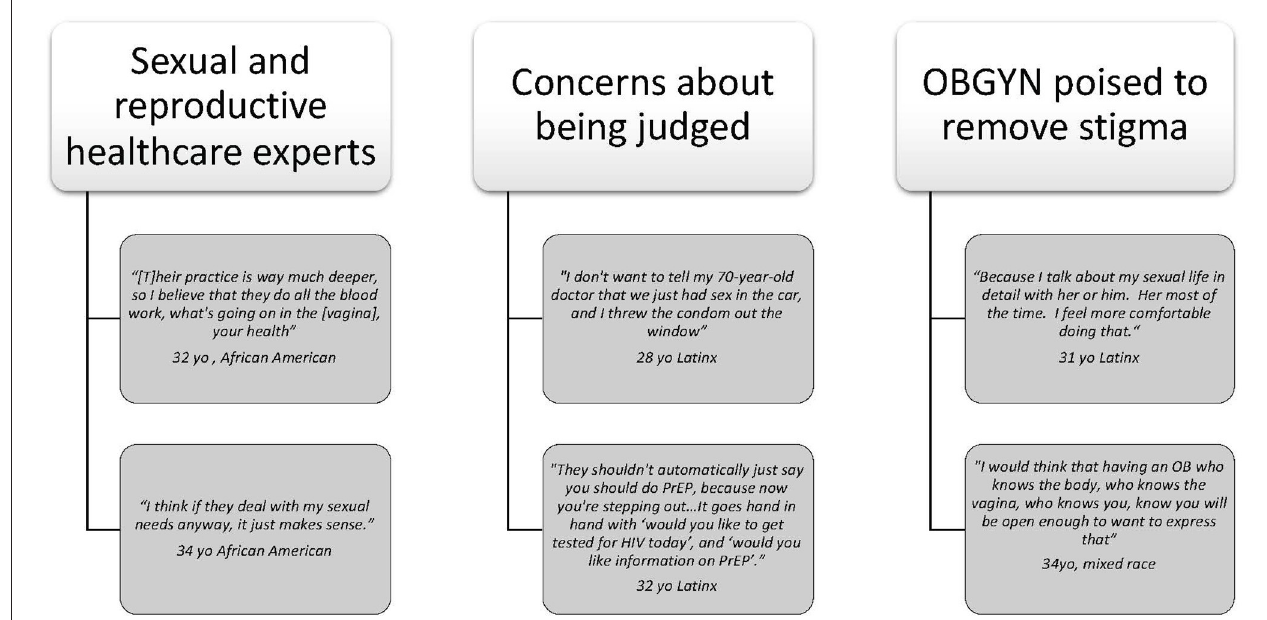
FIGURE 1 | Selected quotes from three main themes.